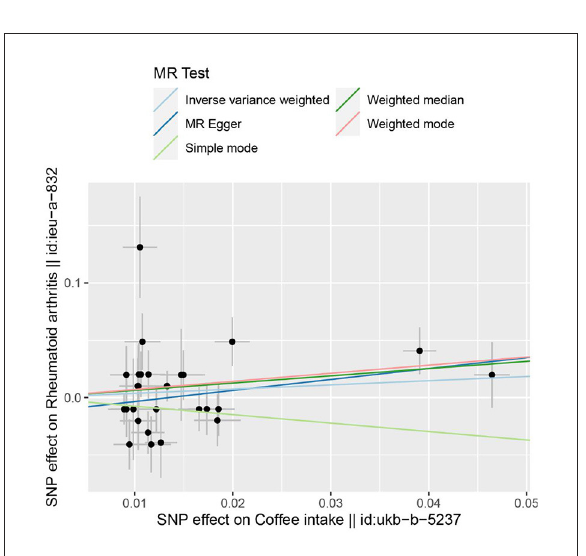
FIGURE2 The scatter plot for MR analyses of causal associations between each coffee intake SNP and